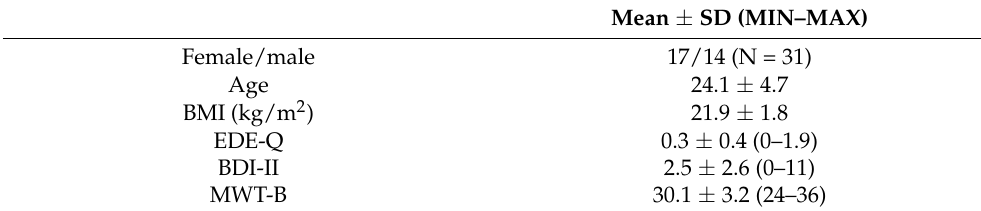
Table 1. Participant characteristics.